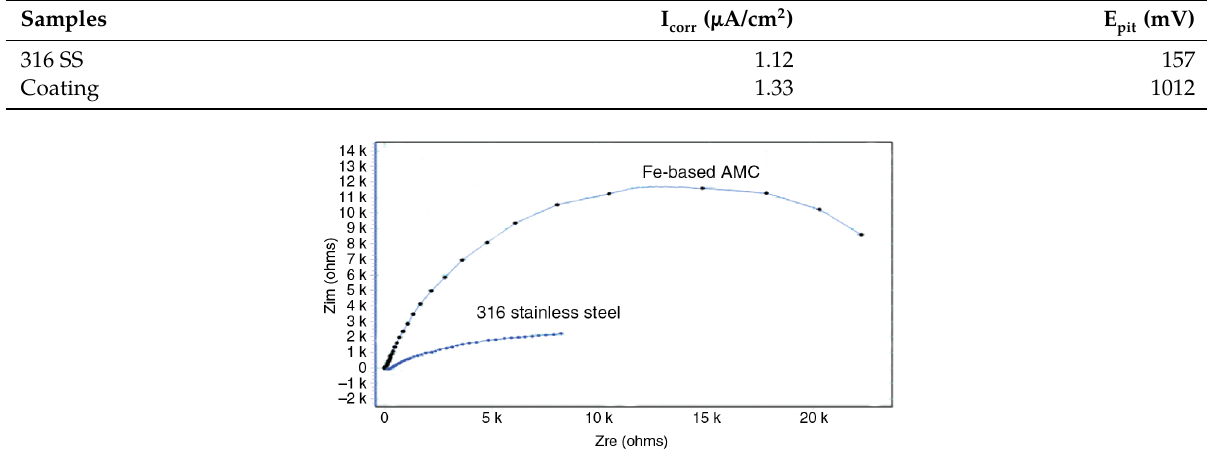
) of AMC coatings and 316 stainless steel. pit